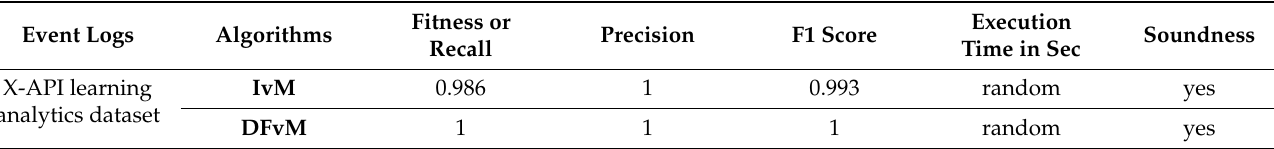
Table 4. Comparison of the process mining algorithms.